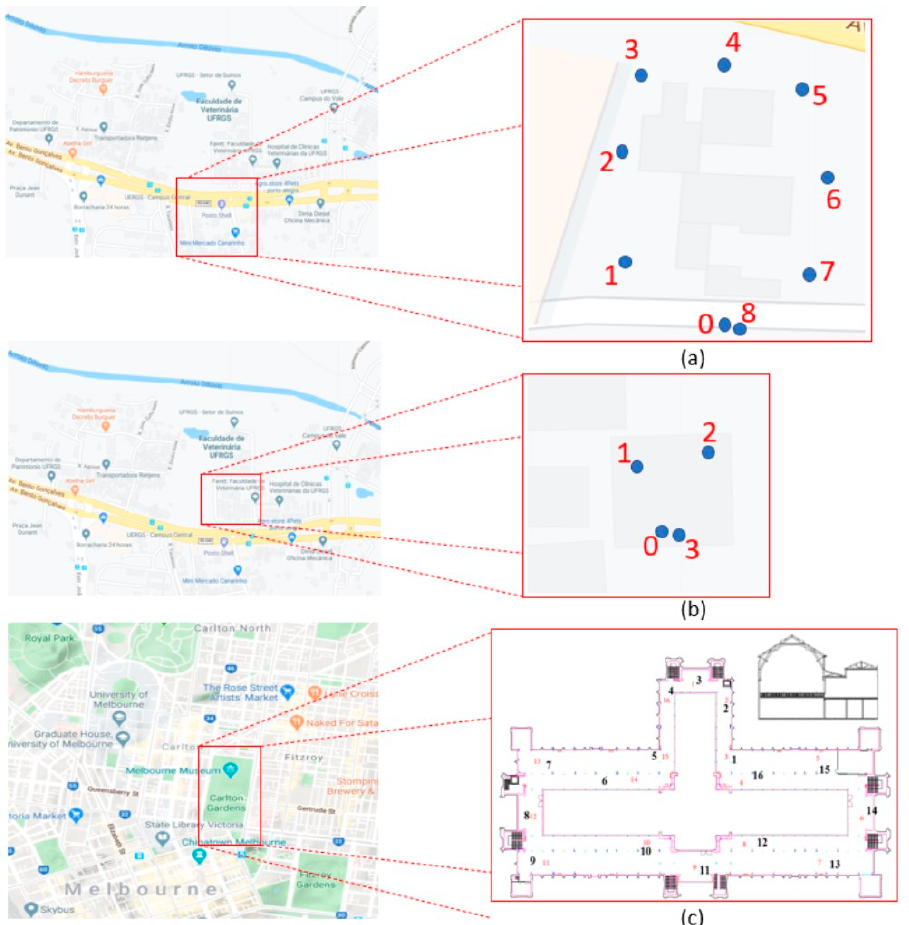
Figure 1. Marker position of each dataset. ( a ) “Patio Batel” dataset, ( b ) “Lape” dataset and ( c ) “Royal building exhibition” dataset.